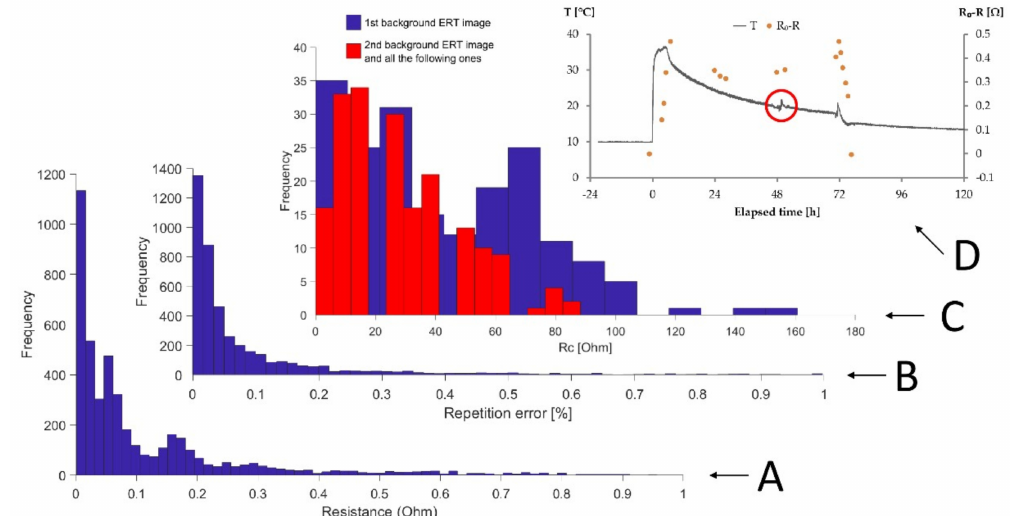
Figure 3. Histograms presenting ( A ) the distribution of the electrical resistance values of the second background data set (with values < 1 Ω ), ( B ) the distribution of the repetition errors for the second background data set, and ( C ) the distribution of the contact resistances R C for the first (blue) and second (red) background data sets. ( D ) shows the evolution of the mean value of our data sets during the experiment and the e ff ect of the pump test (Table 2) on the temperature curve recorded in